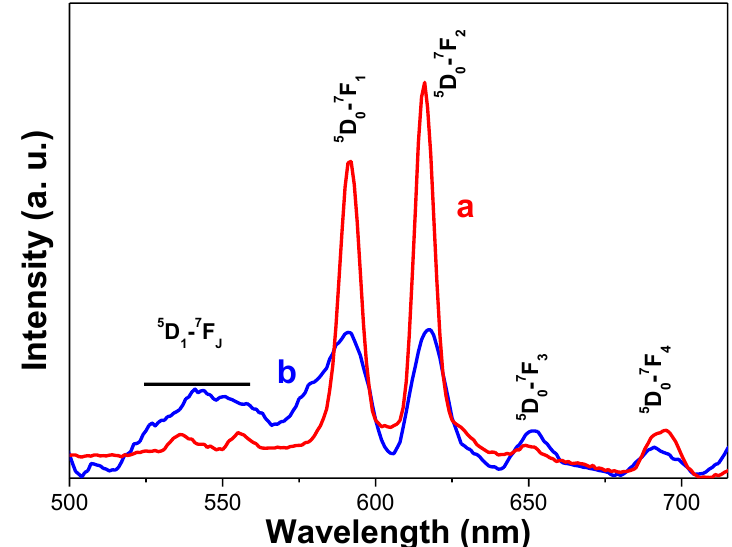
Figure 8. Photoluminescence (PL) spectra of (a) the core and (b) composite based colloids for a continuous excitation at 396 nm.